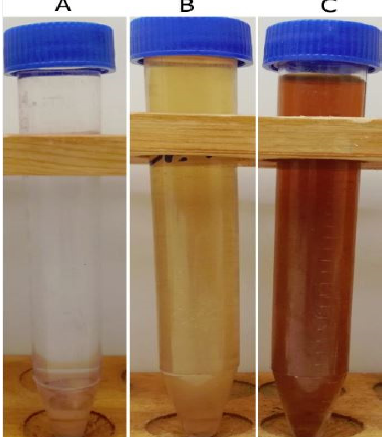
Figure 1. Change in the color of silver nitrate solution after addition of Origanum majorana aqueous leaf extract. ( A ): colorless silver nitrate solution; ( B ): Origanum majorana aqueous leaf extract; ( C ): dark brown color indicates formation of silver nanoparticles.